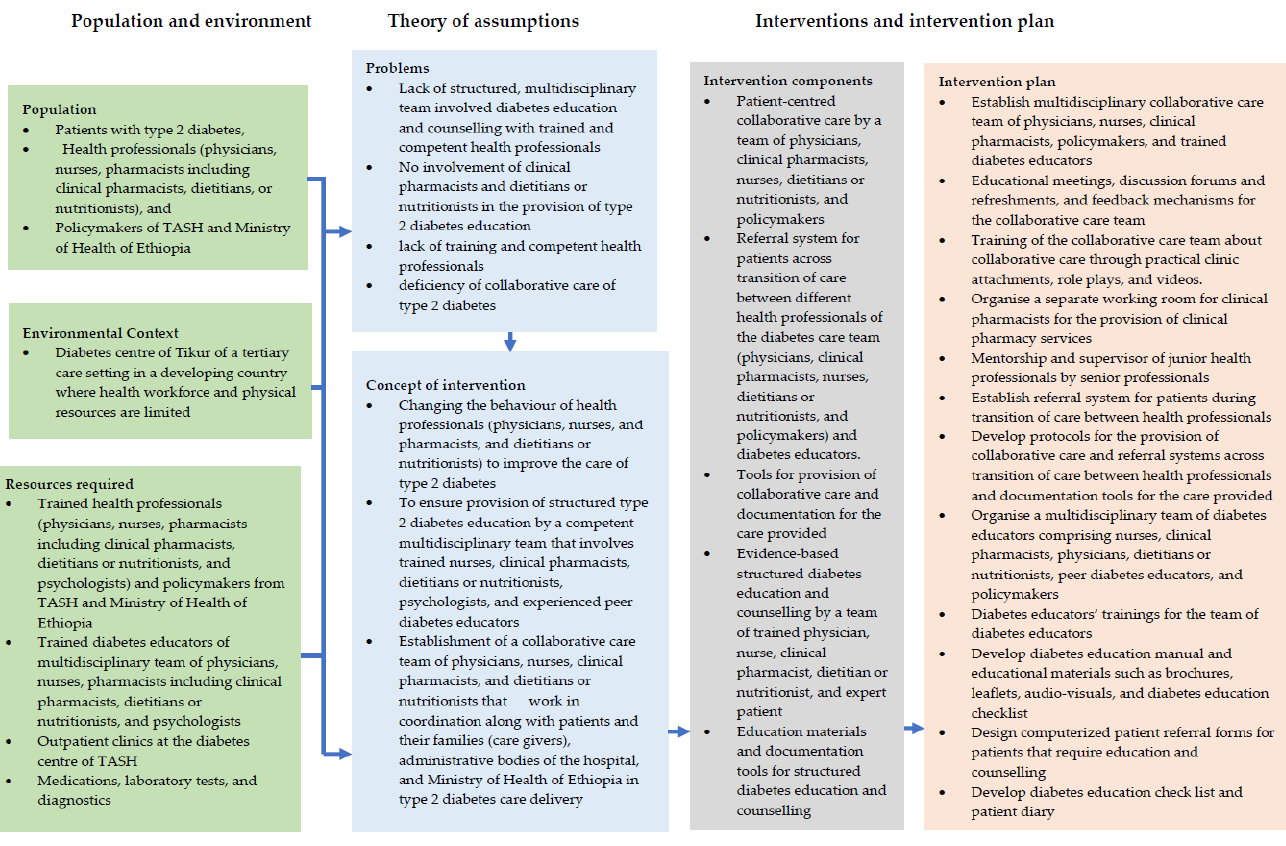
Figure 5. Logic Model linking context of the healthcare system, resources, and intervention activities (Conrad et al,1999)